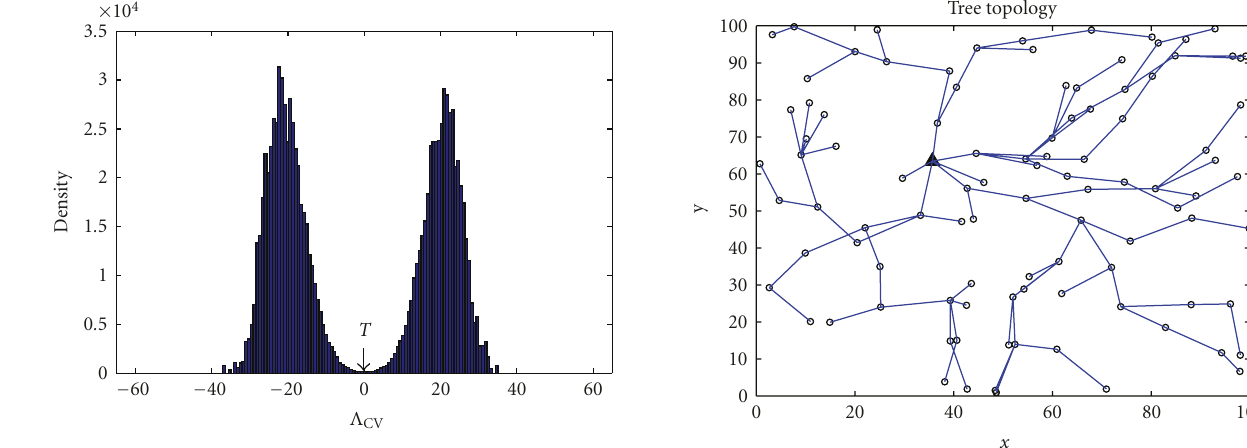
most significant bit is 0 or 1 as appropriate, in equal